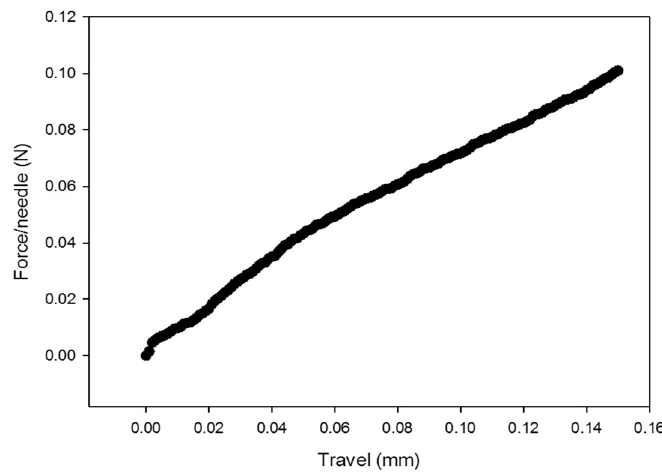
Figure 4. Force travel-curve of the MLPs.